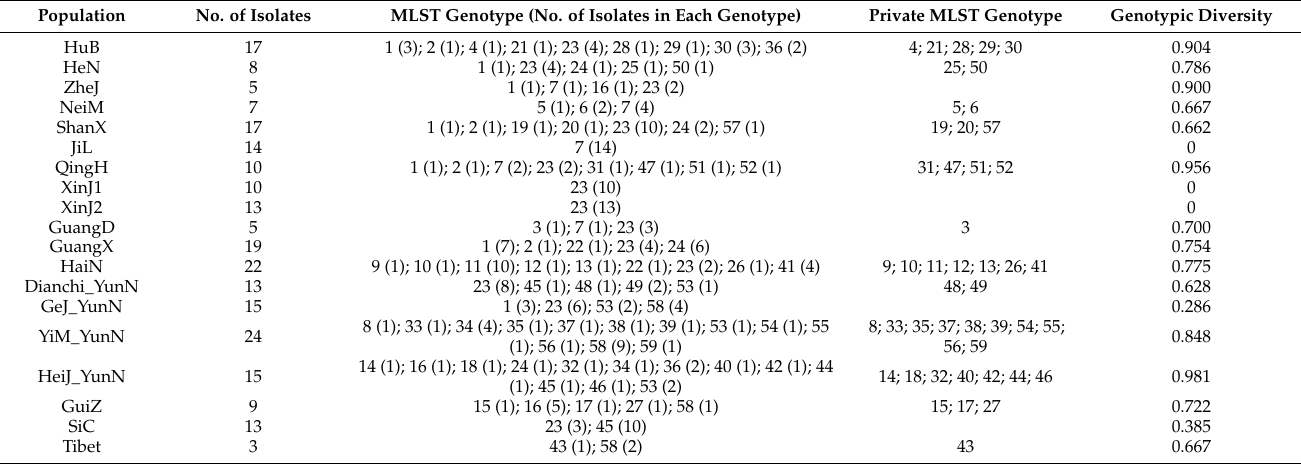
Table 3. Distribution and diversity of MLST genotypes from 19 geographic populations of A. oligospora in